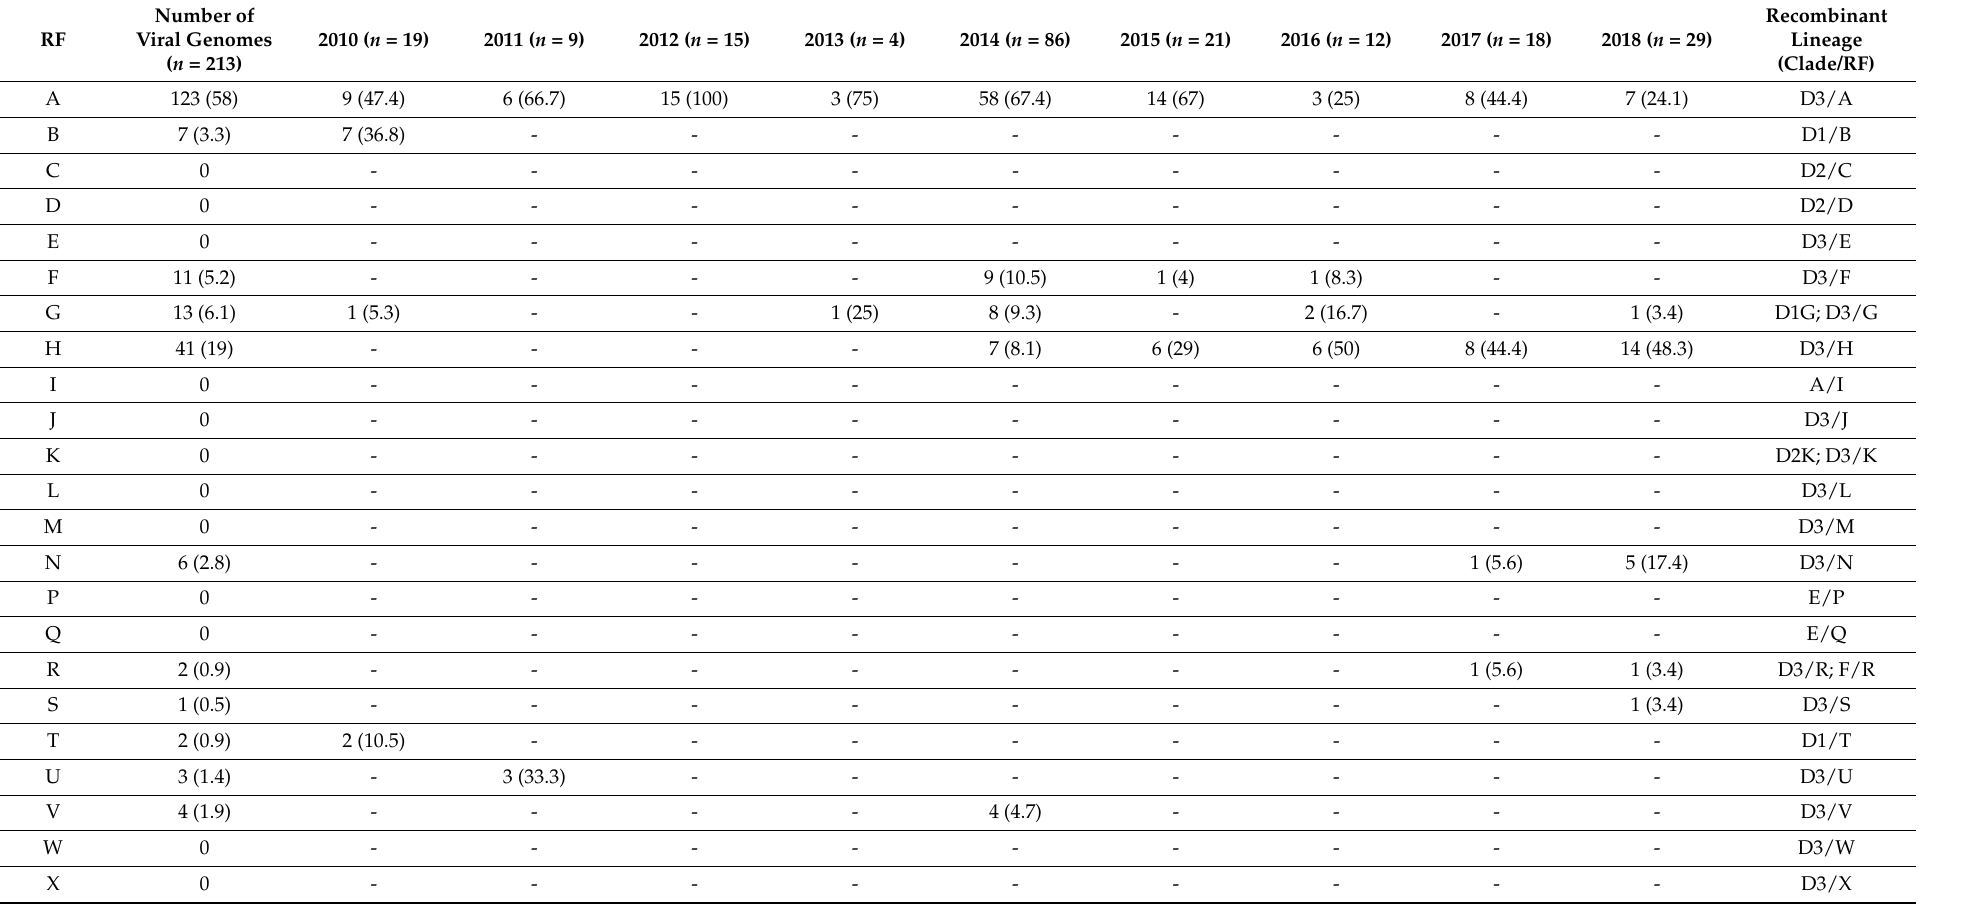
Table 3. Yearly distribution of recombinant forms (RFs) among coxsackievirus A6 complete genomes associated with hand-foot-and-mouth disease/herpangina in